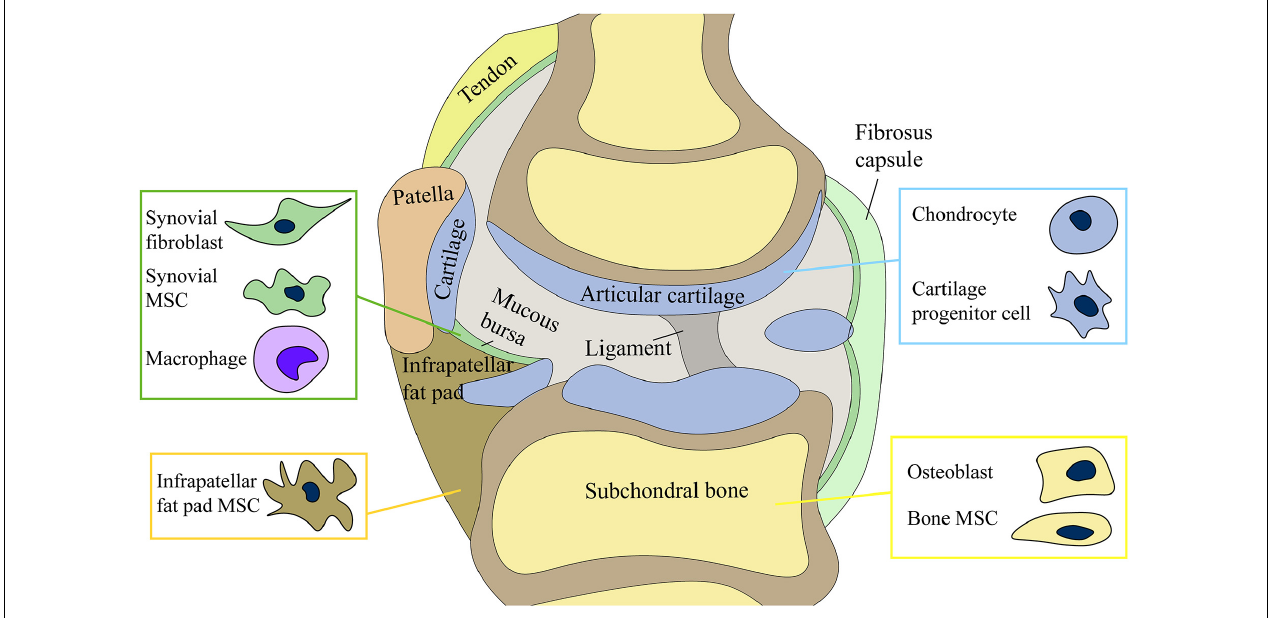
FIGURE 1 | Joint cells) include chondrocytes, osteoblasts of subchondral bone, synovial mesenchymal stem cells (MSCs) and fibroblasts, and infrapatellar fat pad MSCs. The production and release of exosomes by stem cells may be involved in the regulation of joint homeostasis.